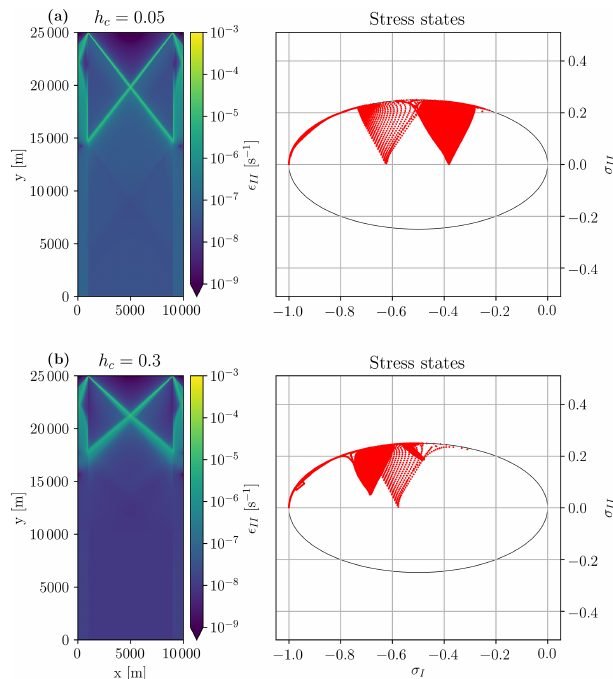
Figure 8. Maximum shear strain rates (left) and stress state in stress invariant space (right) after 5s of integration for different confine- ment pressure: h c = 0 . 05m (a) and h c = 0 . 3m (b) . Note how stress states with divergent strain rates (a) migrate left towards convergent strain rates (b)